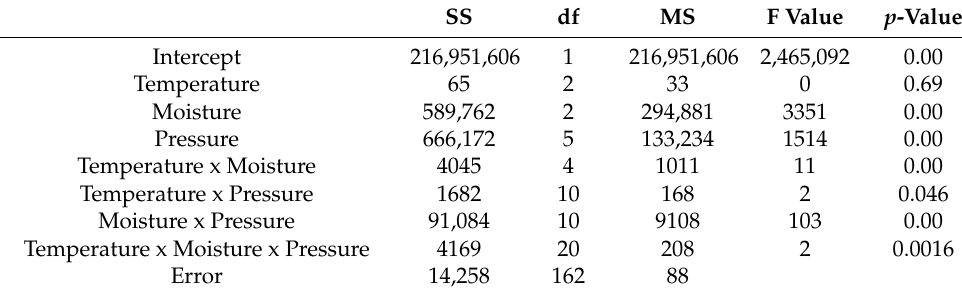
Table 1. Three-way ANOVA results for specific density.